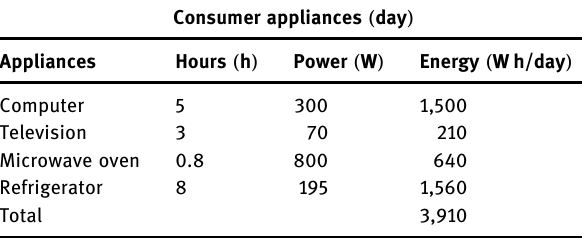
Table 3: Consume appliances per